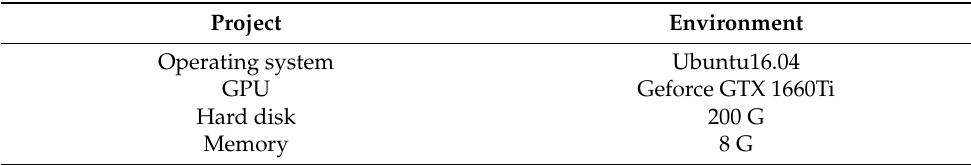
Table 1. Experimental environment.